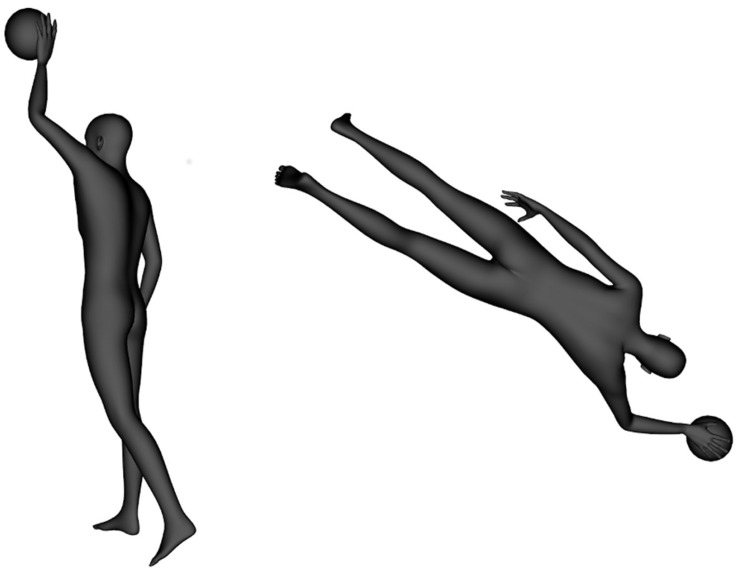
Examples of two stimuli. The left was rotated around the longitudinal axis (60°), the right around the depth axis (120°).